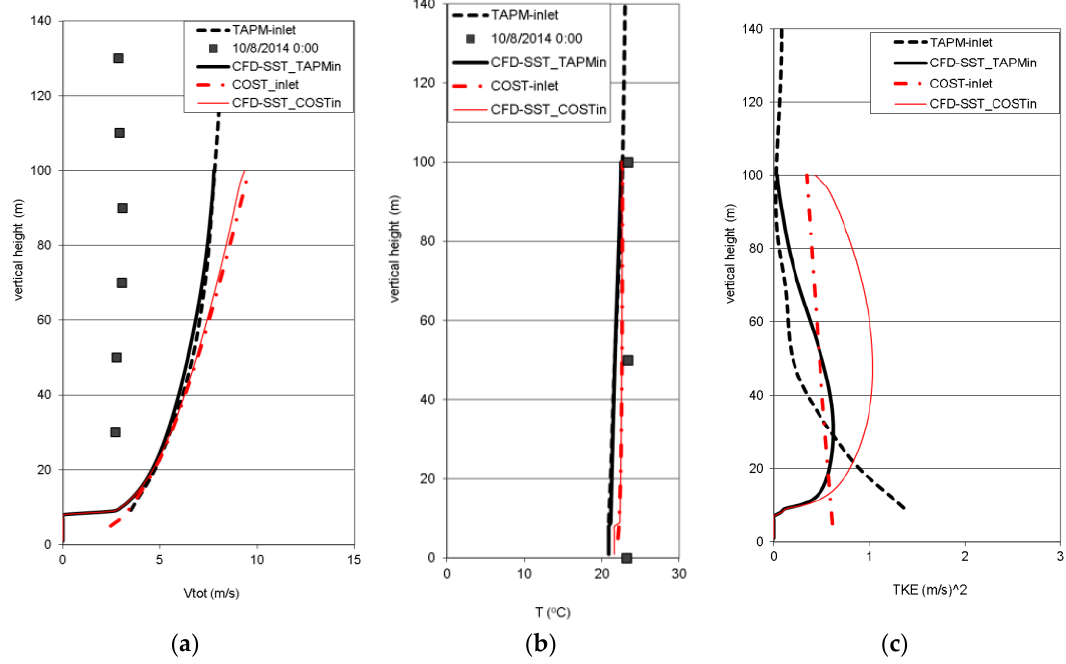
Figure 11. ( a ) Vertical profiles of wind speed and ( c ) wind turbulence kinetic energy over position 2 and ( b ) air temperature over position 1 (Figure 1). CFD results, neutral atmosphere (E in Table 1), SST turbulence model and inlet profiles from mesoscale results (“TAPM - inlet”) and from the COST 710 recommendations (“ COST- inlet”) .